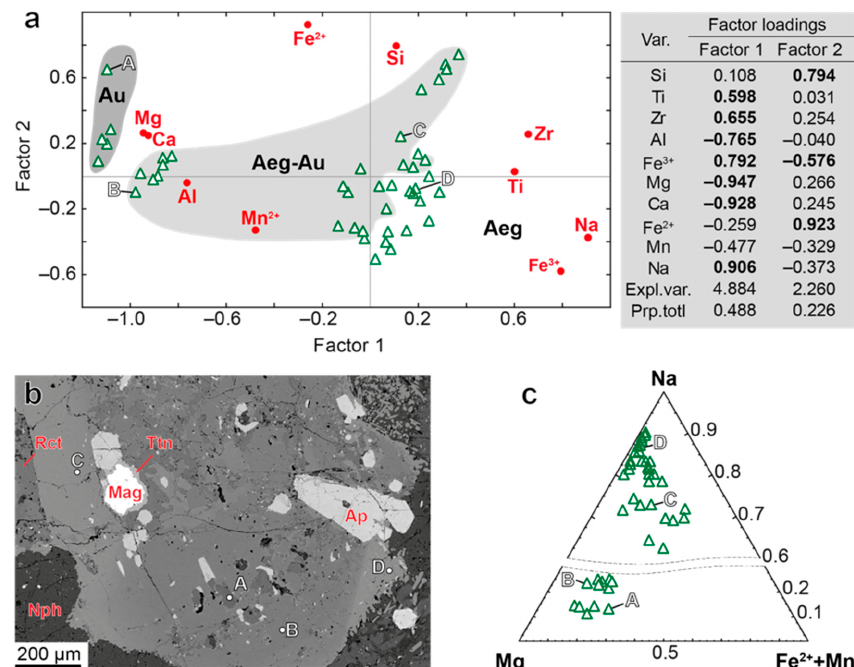
Figure 13. Chemical composition of clinopyroxenes from metasomatic rocks of the Alluaiv site: ( а )— results of factor analyses. Points on a gray background correspond to augite (Au) and aegirine-augite (Aeg-Au), with other points corresponding to aegirine (Aeg). Points A–D correspond to Figure 13b,c. Var.—variables; Expl.var.—Explained variance; Prp.totl—proportion of total variance. Factor loadings > | 0.5 | are shown in bold. ( b )—relicts of augite surrounded by rims of aegirine-augite and aegirine in a metasomatic rock 156 / 89. The compositions corresponding to points A–D are shown in Figure 13a,c; (c) —compositional variation of clinopyroxenes in Mg–(Fe 2 + + Mn)–Na